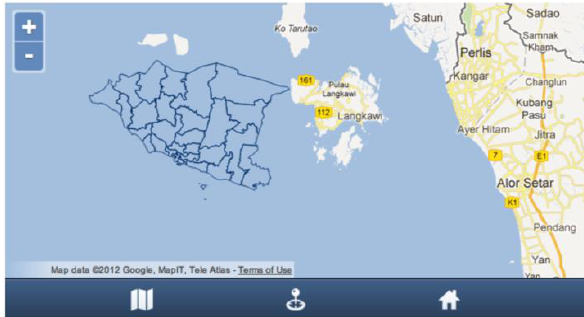
Figure 2. The Projection of Data Source is Hotine Oblique Mercator Table 1. Determining the Map Projection Method Based on the 2. HOTINE OBLIQUE MERCATOR